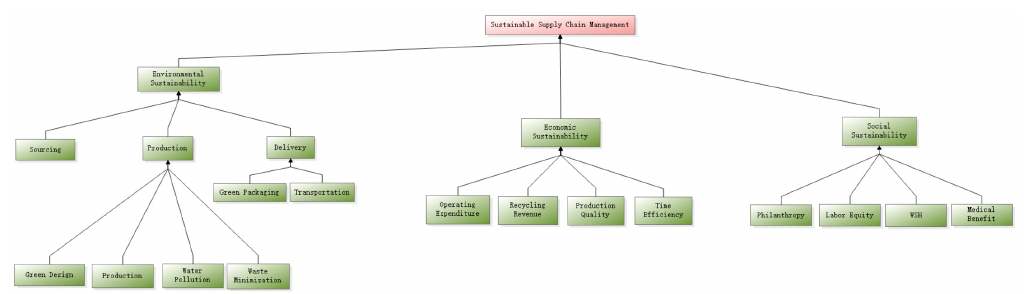
Figure 3. The Hierarchy Structure for factors affecting supply chain sustainability.